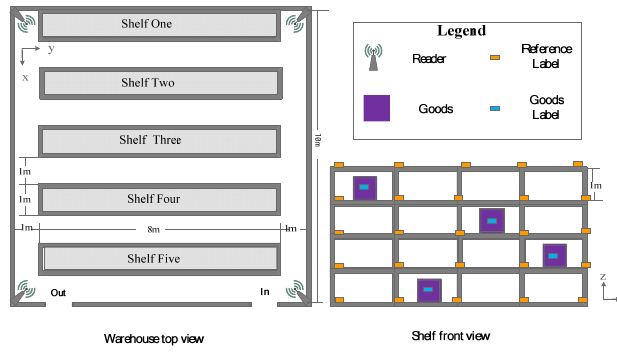
Figure 4. Warehouse abstract layout.